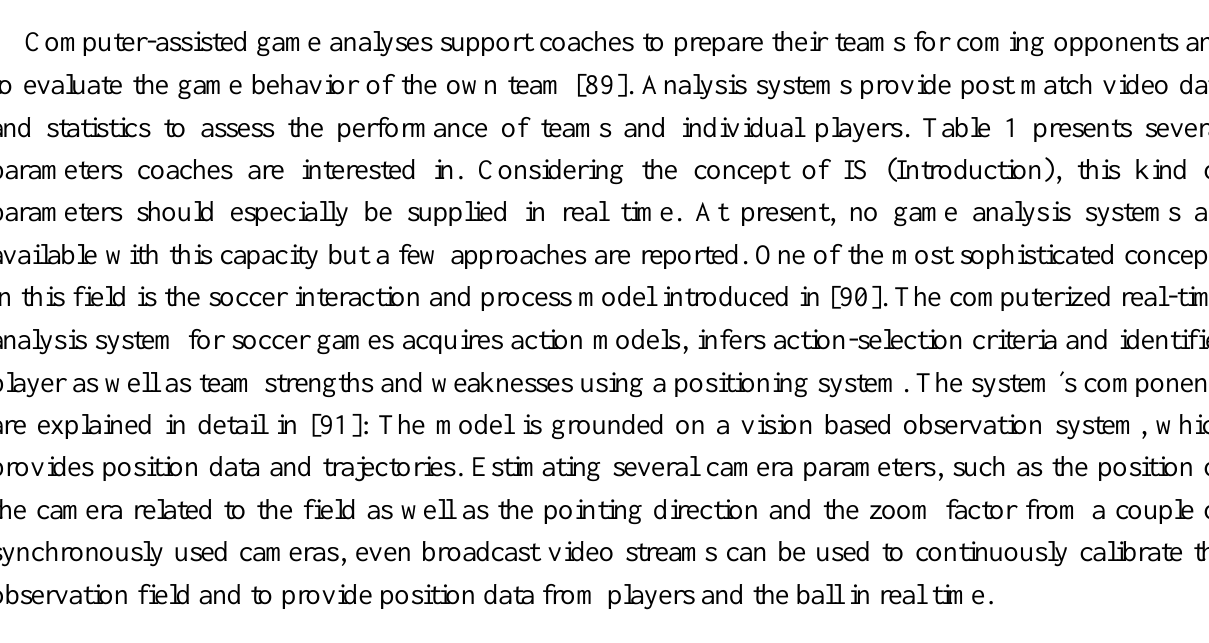
Figure 2. Hierarchical structured models for analyzing soccer games based on position data ([91], with